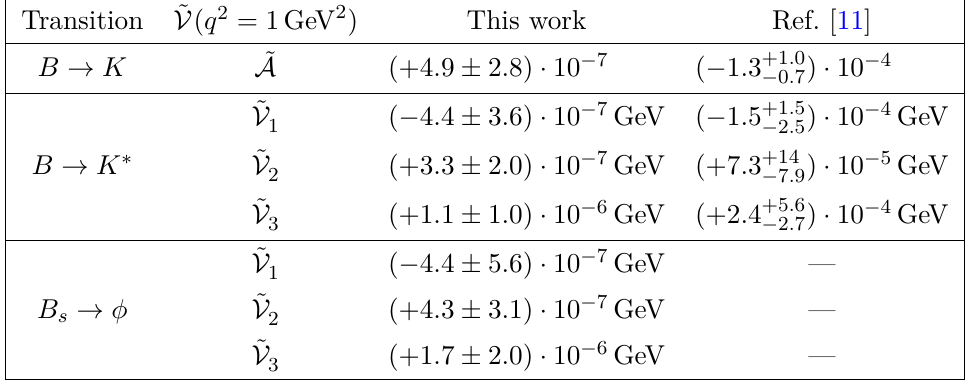
Table 3 . Comparison between the results of ref. [11] and our results at q 2 = 1 GeV 2